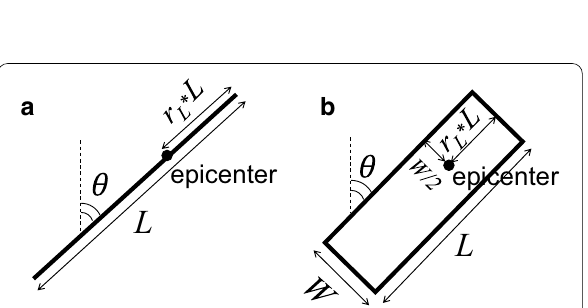
Fig. 4 Diagrams of the geometry of the a line-source and b rectangle-source models. The black circle shows the epicenter location